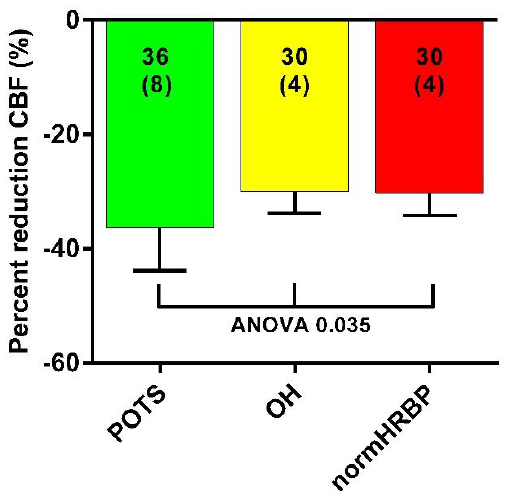
Figure 2. Cerebral blood flow reduction in long-haul COVID-19 patients with POTS, with orthostatic hypotension, and with a normal heart rate and blood pressure during the tilt test. CBF: cerebral blood flow; OH: orthostatic hypotension; normHRBP: normal heart rate and blood pressure response during the tilt test.